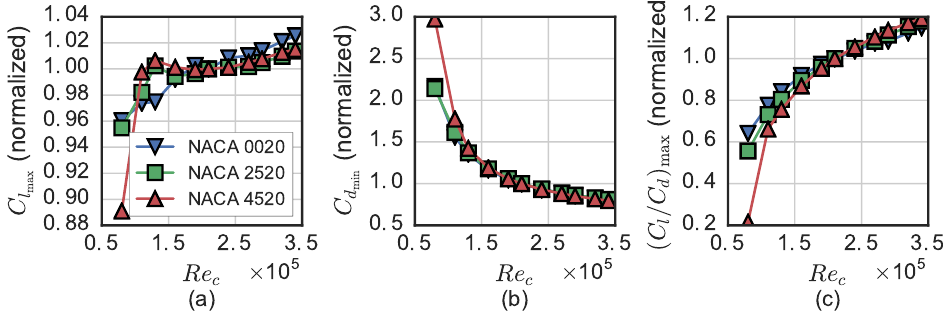
Figure 7. Normalized maximum lift coefficient ( a ), drag coefficient ( b ), and lift-to-drag ratio ( c ) computed by XFOIL at various Re c for each profile.